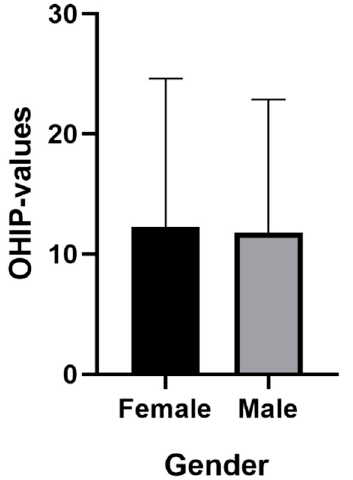
Figure 2. Mean (standard error) for gender.